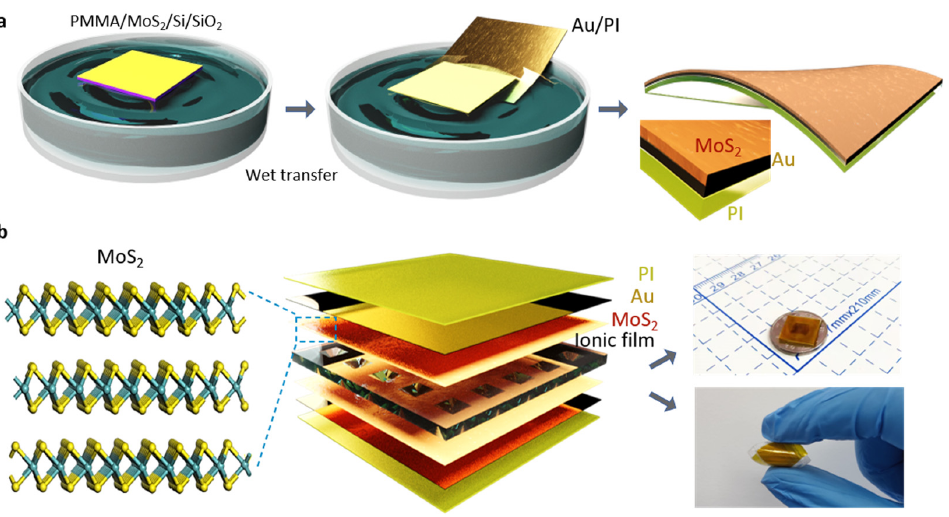
Figure 1. Preparation and schematic diagram of iontronic pressure sensor. ( a ) Wet transfer process of MoS 2 monolayer. ( b ) Digital optical image and flexible feature of iontronic pressure sensor and the corresponding diagram layout of each layer in the sensor.